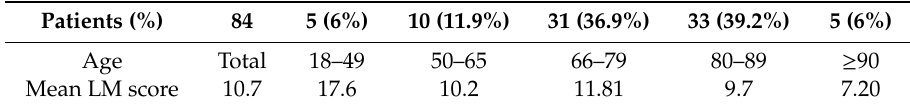
Table 1. Age make-up of the cohort * and their associated mean logical memory (LM) scores. Patients (%)